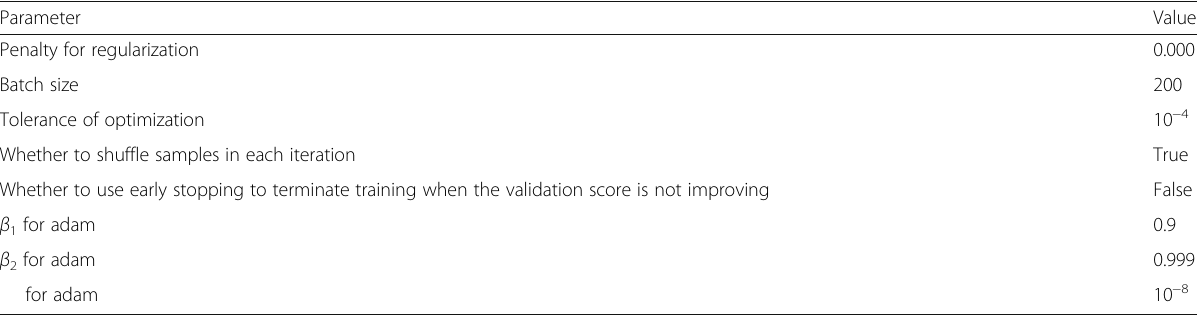
Table 1 Parameters for the MLP classifier included in scikit-learn0.18.1. These are the same as commonly used values. See Kingma and Ba (2015) for the meanings of the parameters for the Adam optimizer